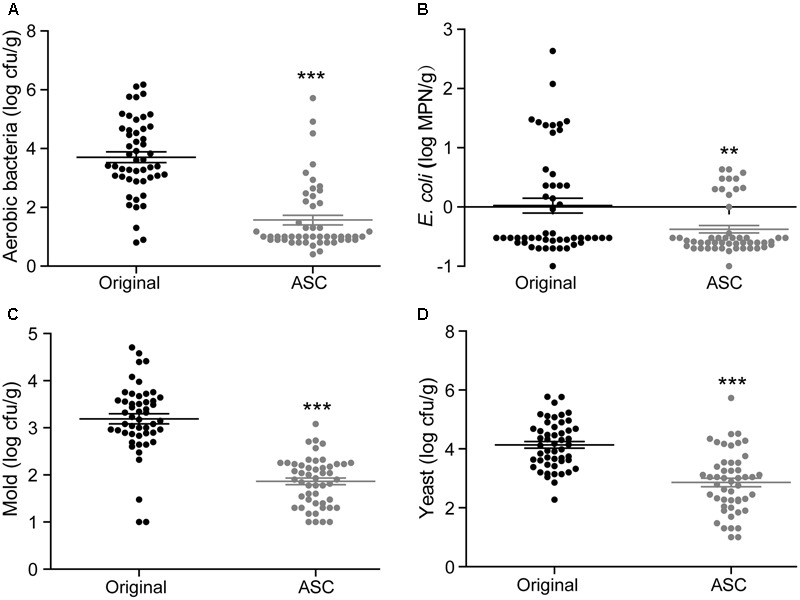
Effects of 0.1% ASC treatment on aerobic bacteria (A), E. coli
(B), mold (C), and yeast (D) for 50 randomly collected strawberry samples. Data are expressed as mean ± SD (n = 50). ∗∗P < 0.01 and ∗∗∗P < 0.001 versus original.